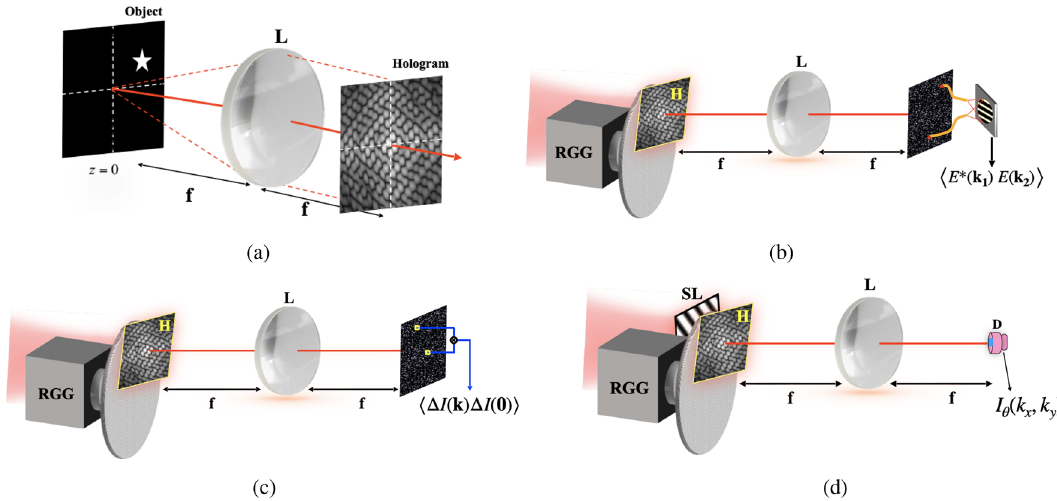
Figure 1. ( a ) Represents coherent recording of complex field of an object located at Z = 0 , L is a lens with focal distance f ( b ) Represents the reconstruction process of the hologram with incoherent light, where L is a lens with focal distance f , RGG is rotating ground glass, H is hologram; ( c ) Represents the PCH setup: intensity correlation holography scheme; ( d ) Represents the STICH setup, where SL is structured light pattern, H is hologram, D is single-pixel